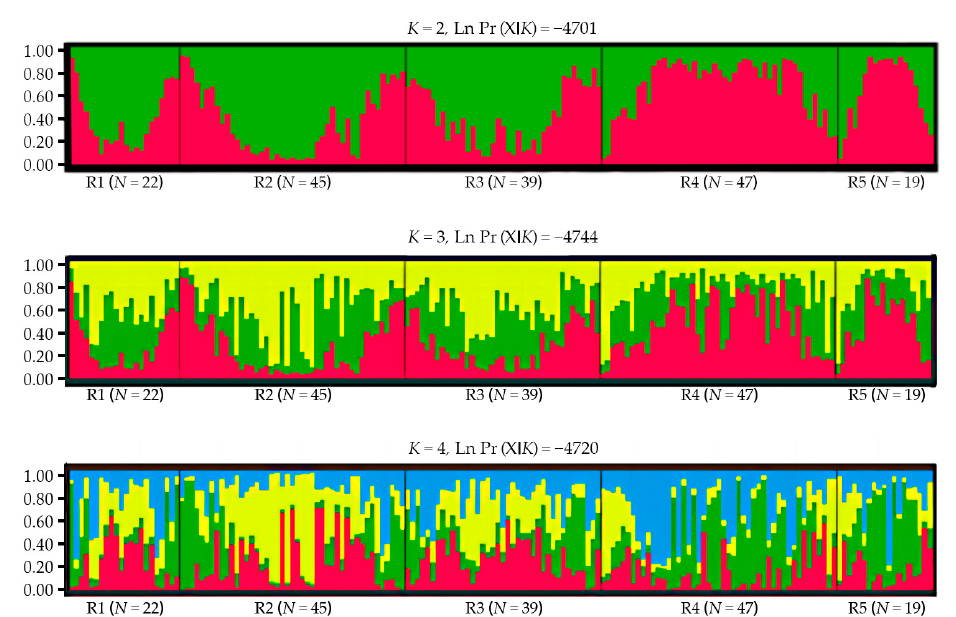
Figure 4. Bayesian clustering results of red deer for the microsatellite ( K = 2–4). A line represents each individual ( N = 172), different colors represent different groups, and the proportions of different colors in the lines are the probability that an individual was assigned to a certain group. Individual numbers of each sampling group are shown at the bottom of the figure.